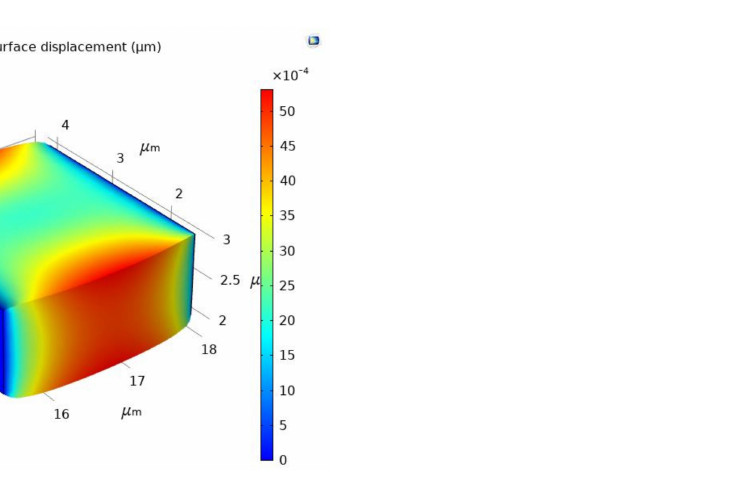
Figure 7. The displacement of the sample surface when the electric field intensity is 300 V/cm. In the flash sintering process, because of the rapid increase of power density in the sample, it is a challenge to accurately measure the temperature of the sample. Therefore, the finite element simulation method was used to measure the temperature of the sample. When the electric field intensity is equal to 300 V/cm, the distribution of the sample surface at the stable stage is shown in Figure 8. Through the finite element simulation analysis of the flash sintering process, the results show that there is a temperature gradient between the surface and the inside of the sample, and the temperature of many parts in the sample surface is greater than 800 K. In [36], the flash sintering process was analyzed by the finite element method. The simulation results show that when the electric field intensity is 120 V/cm, the maximum temperature of the sample reaches 1840 K, which is much higher than 1390 K at the beginning. There are obvious thermal gradients on the surface and inside of the strip specimen. Even on the surface, the temperature gradually decreases from the center to the edge. This is consistent with our results.